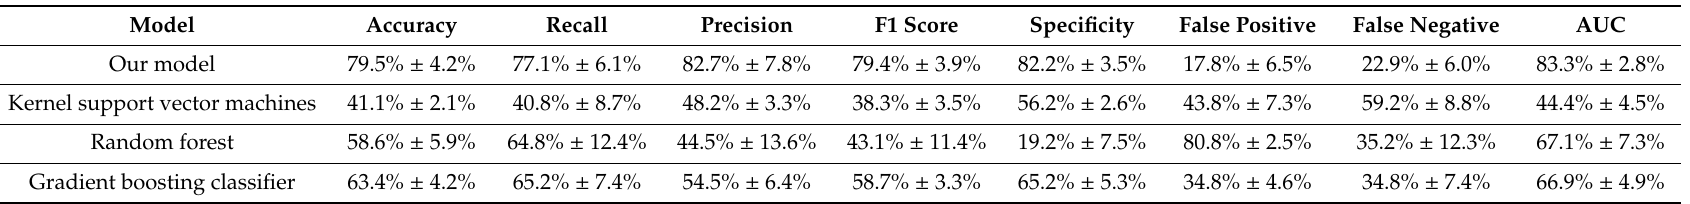
Table 1. Comparison of performance of our model, kernel support vector machines, random forest, and gradient-boosting classifier for detection of wound